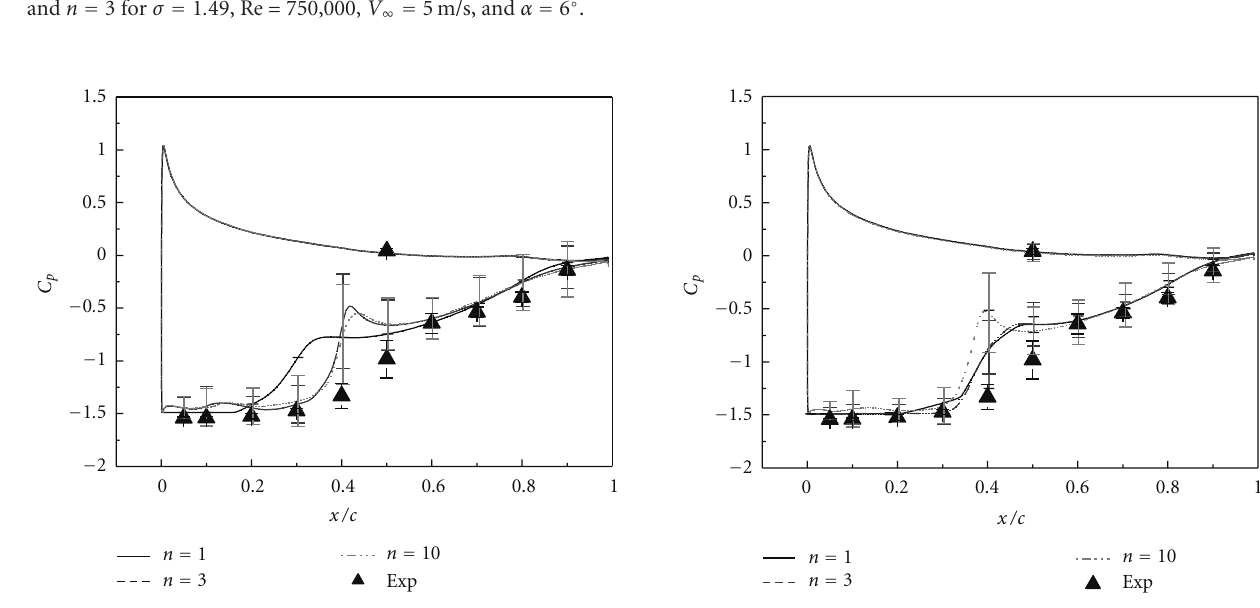
Figure 7: Computed versus measured pressure coe ffi cients for di ff erent n values, Kubota cavitation model, σ = 1 . 49, Re = 750,000, α = 6 ◦ . The lines represent the mean values and V ∞ = 5m/s, and the error bars represent the level of fluctuations.